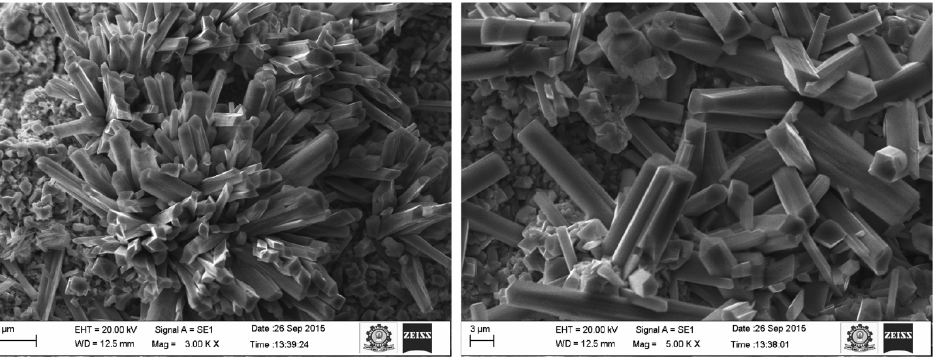
Figure 9: Structure of oxides observed under high magnification of the sample exposed with molten salt at